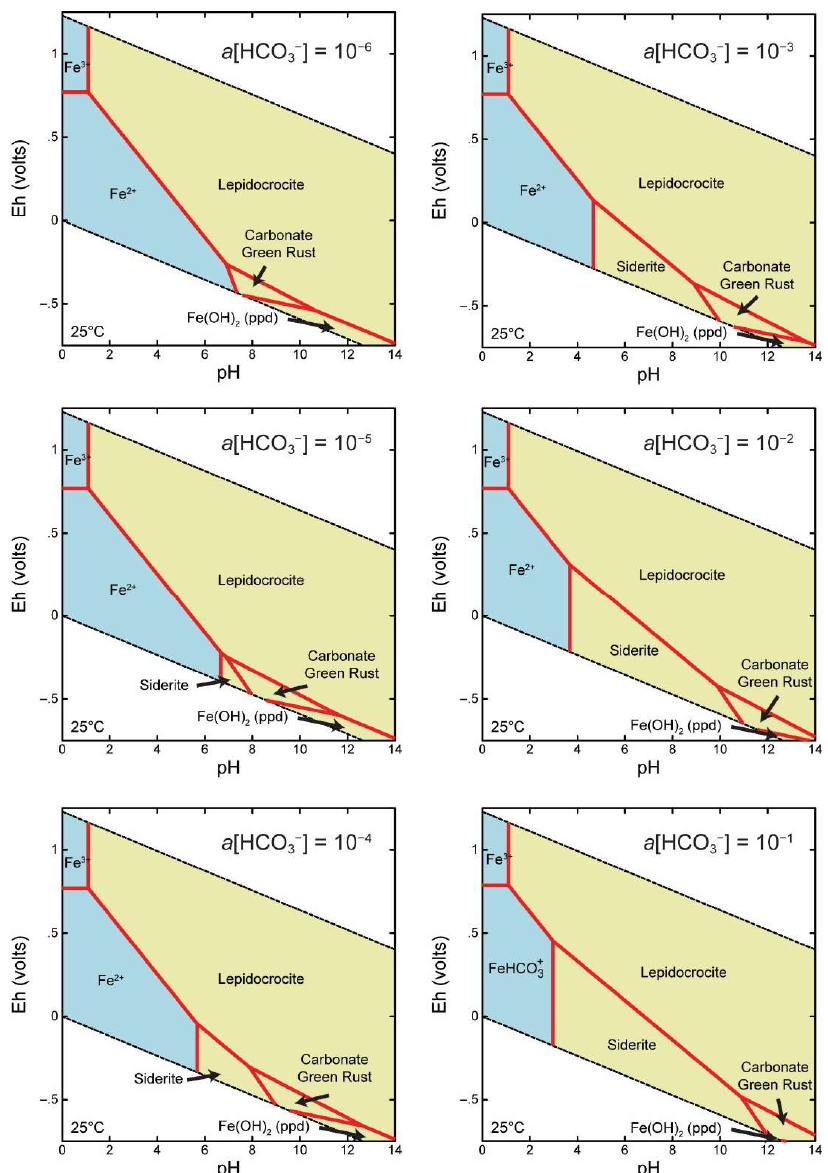
Figure 15. Eh-pH diagrams of iron ( a [Fe 2+ ] = 10 −3 ) in aqueous solution containing dissolved carbonate ranging from a [HCO 3− ] = 10 –6 –10 –1 at 30 °C.